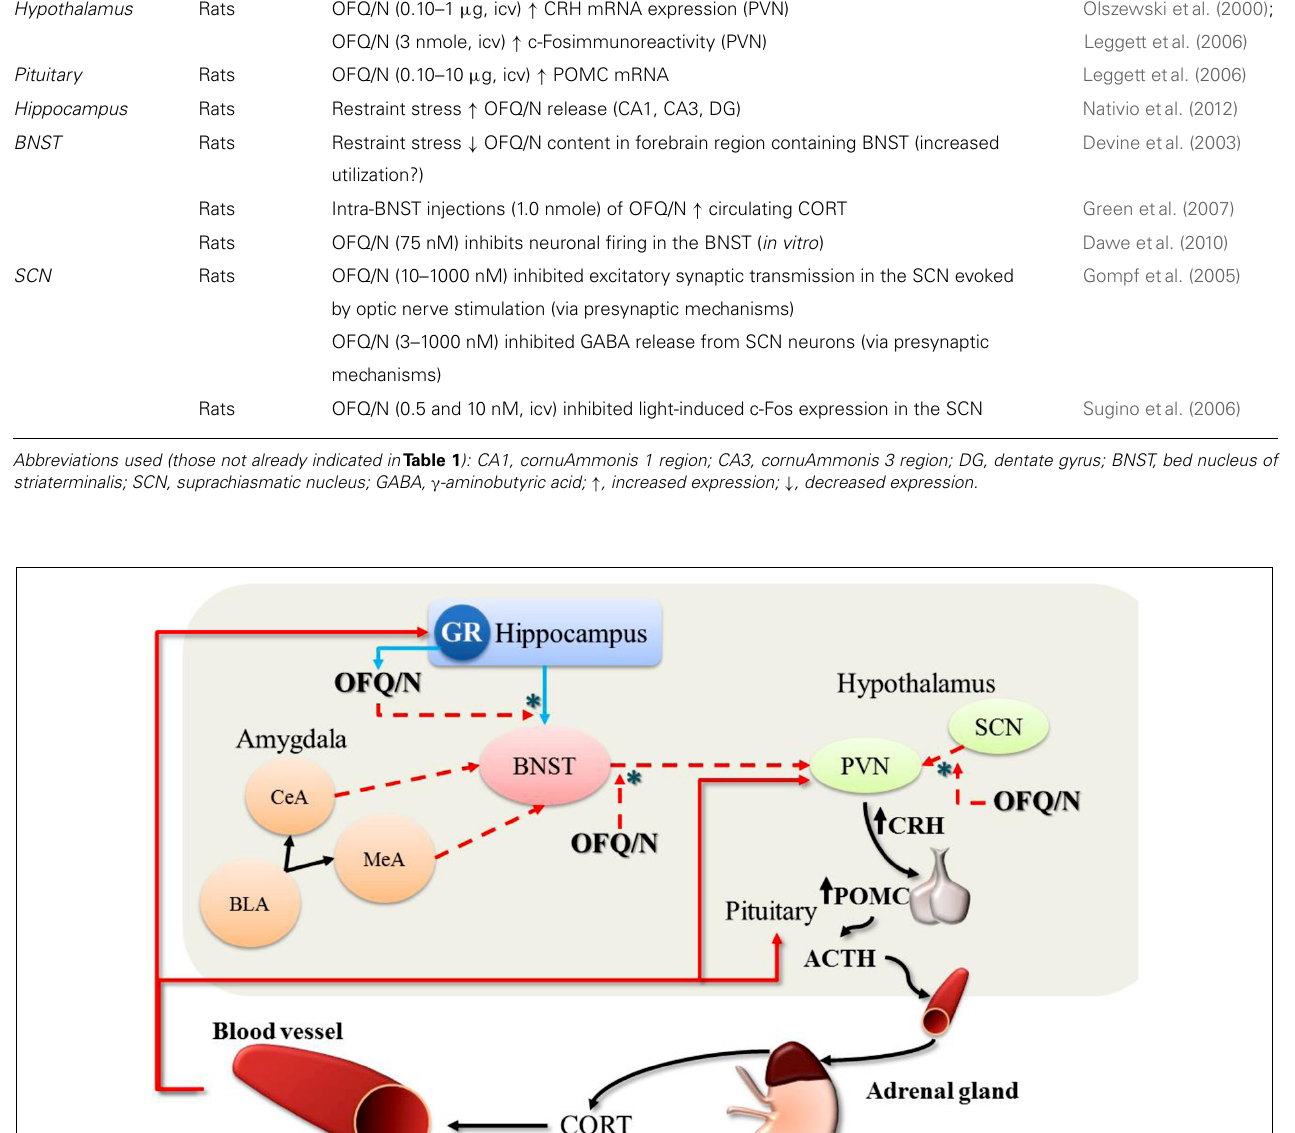
Table 2 | Putative neural substrates mediating the stimulatory effects of OFQ/N on the hypothalamic-pituitary-adrenal (HPA) axis. Region